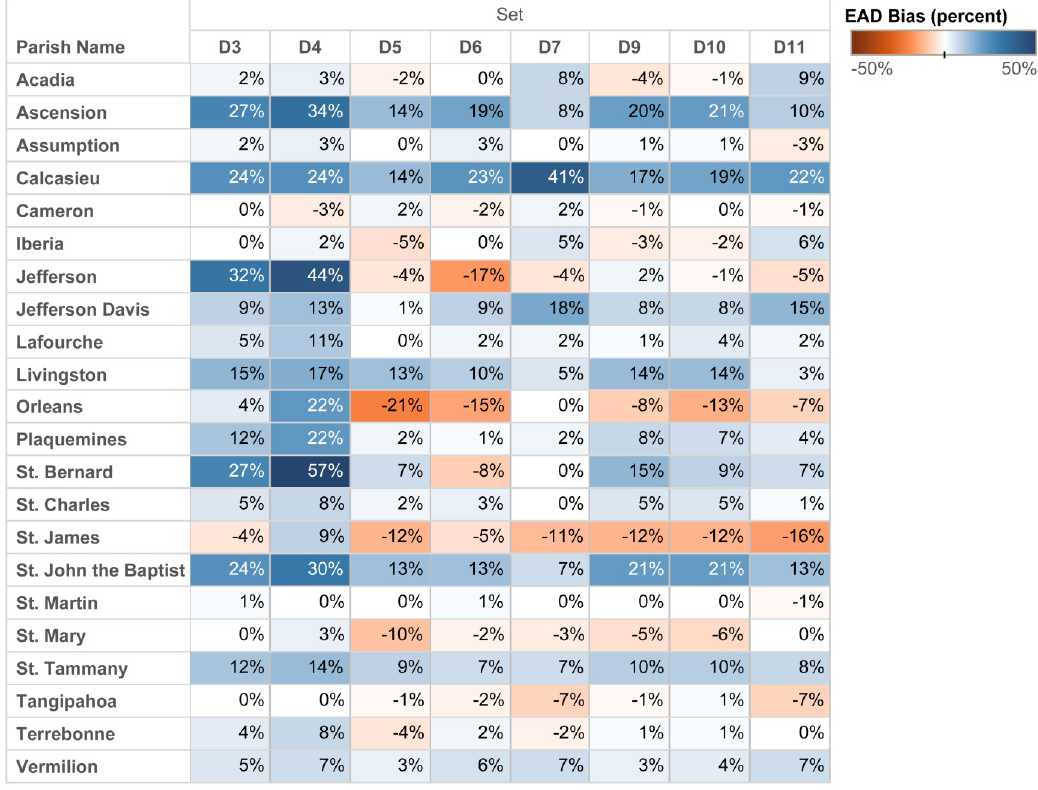
Figure 11. Percentage bias in expected annual damage by parish (median).